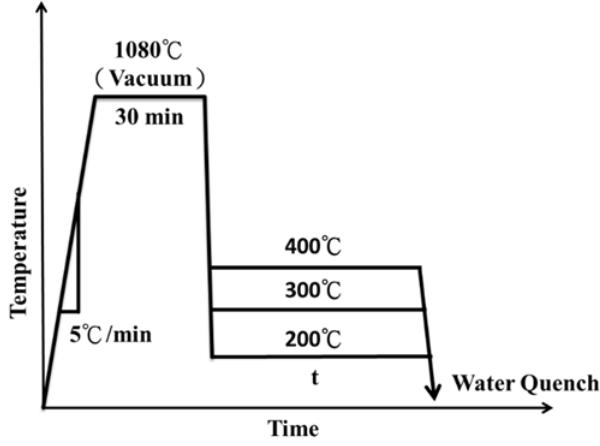
Figure 2. The tempering process with different salt ‐ bath temperatures.